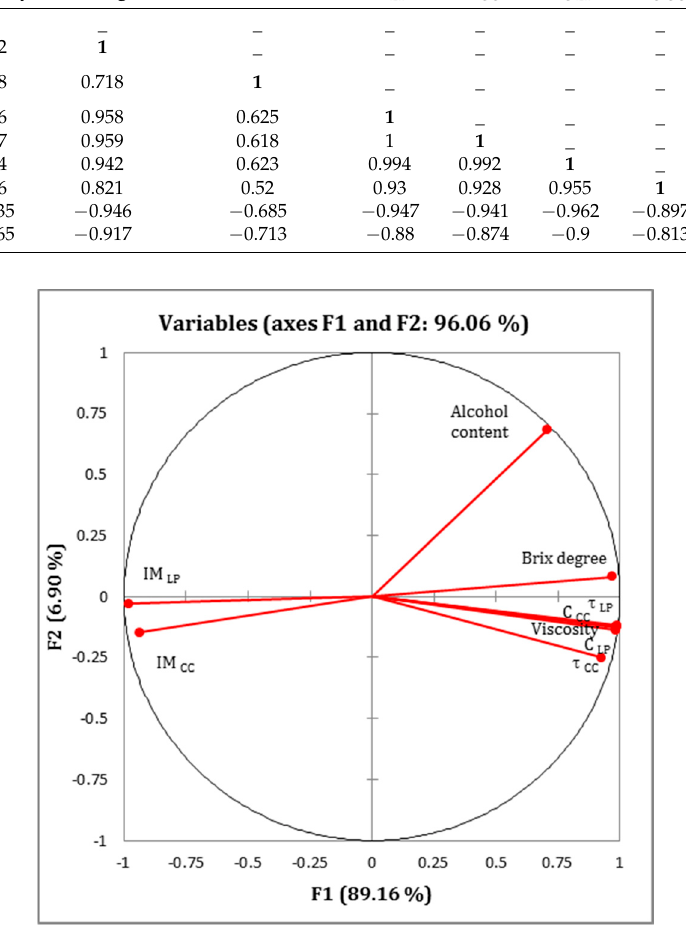
Figure 6. Pearson correlation circle representing the variables projected on the first principal component F1 and the second principal component F2 for all wine samples.